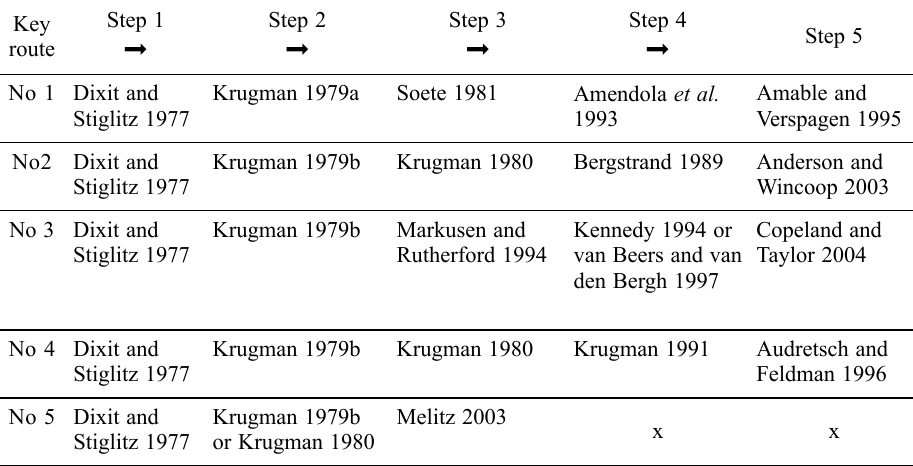
Table 1. Five main paths in international